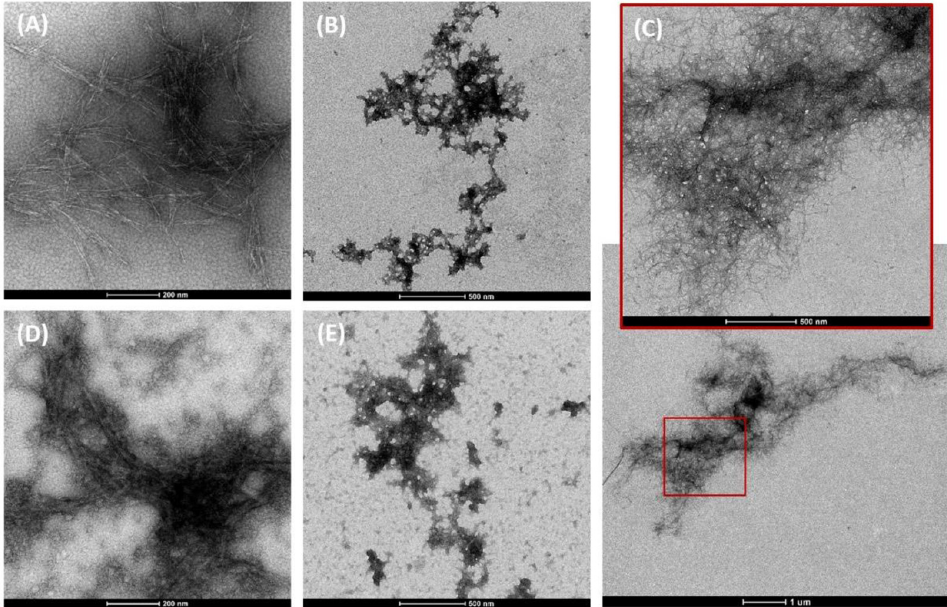
Figure 1. TEM images of the three cellulose nanomaterials dispersed in PBS ( A – C ) or complete RPMI cell culture medium ( D , E ). ( A , D ) CNC obtained by acid hydrolysis; ( B , E ) CNF obtained via an enzymatic treatment; ( C ) CNF obtained by TEMPO. Reproduced with permission from [47], Nanomaterials , published by MDPI, 2022.